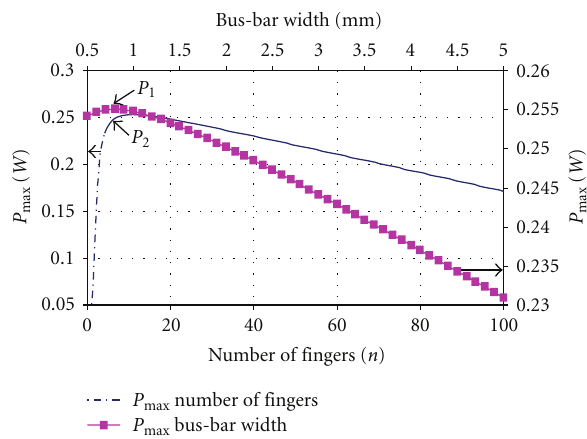
Figure 3: Optimization of P max from iterating number of fingers and bus-bar width.